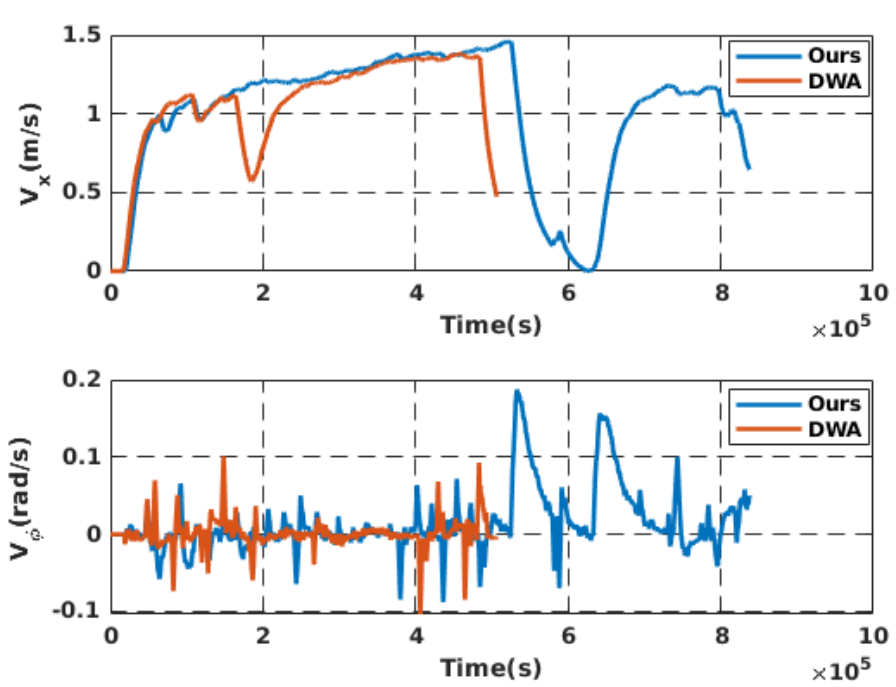
Figure 12. ( Top ): The commanded forward velocity in simulation. ( Bottom ): The commanded heading rate of